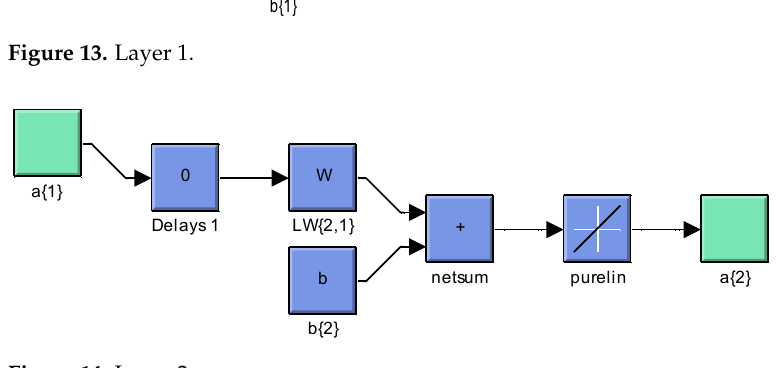
Figure 14. Layer 2. Figure 14. Layer